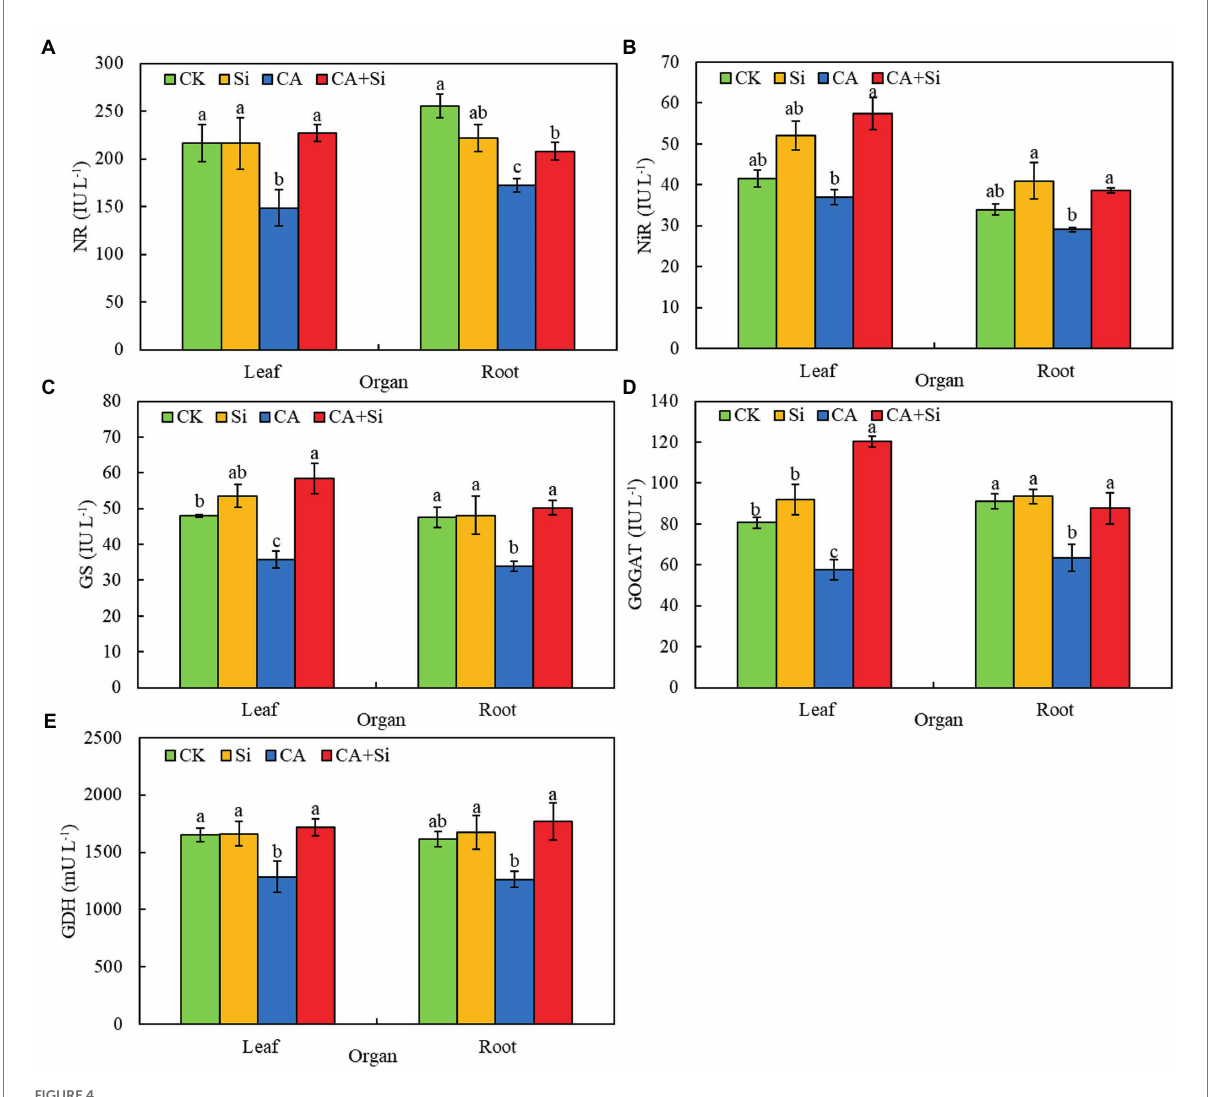
FIGURE 4 Effect of exogenous Si on the enzyme activities of nitrate reductase (NR; A ), nitrite reductase (NiR; B ), glutamine synthase (GS; C ), glutamate synthase (GOGAT; D ), and glutamate dehydrogenase (GDH; E ) in the leaves and roots of cucumber seedlings under cinnamic acid-induced autotoxicity stress. Vertical bars represent the mean ± SE from three independent replicates. Different lowercase letters indicate significant differences according to Duncan’s multiple range test ( p <